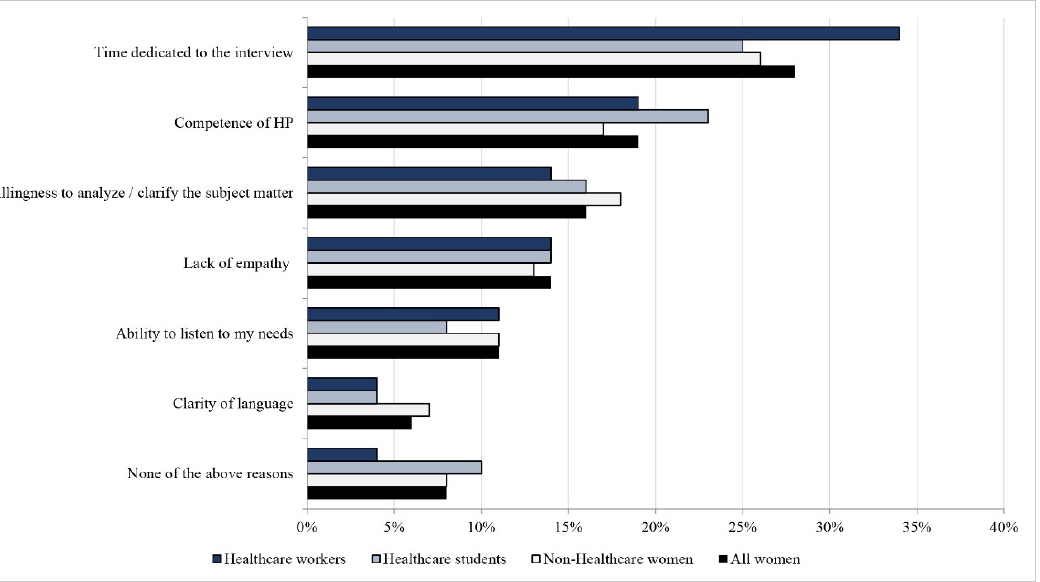
Figure 2 . Distribution of the most critical issues reported by women not completely satisfied with healthcare professionals ( N = 4414) .